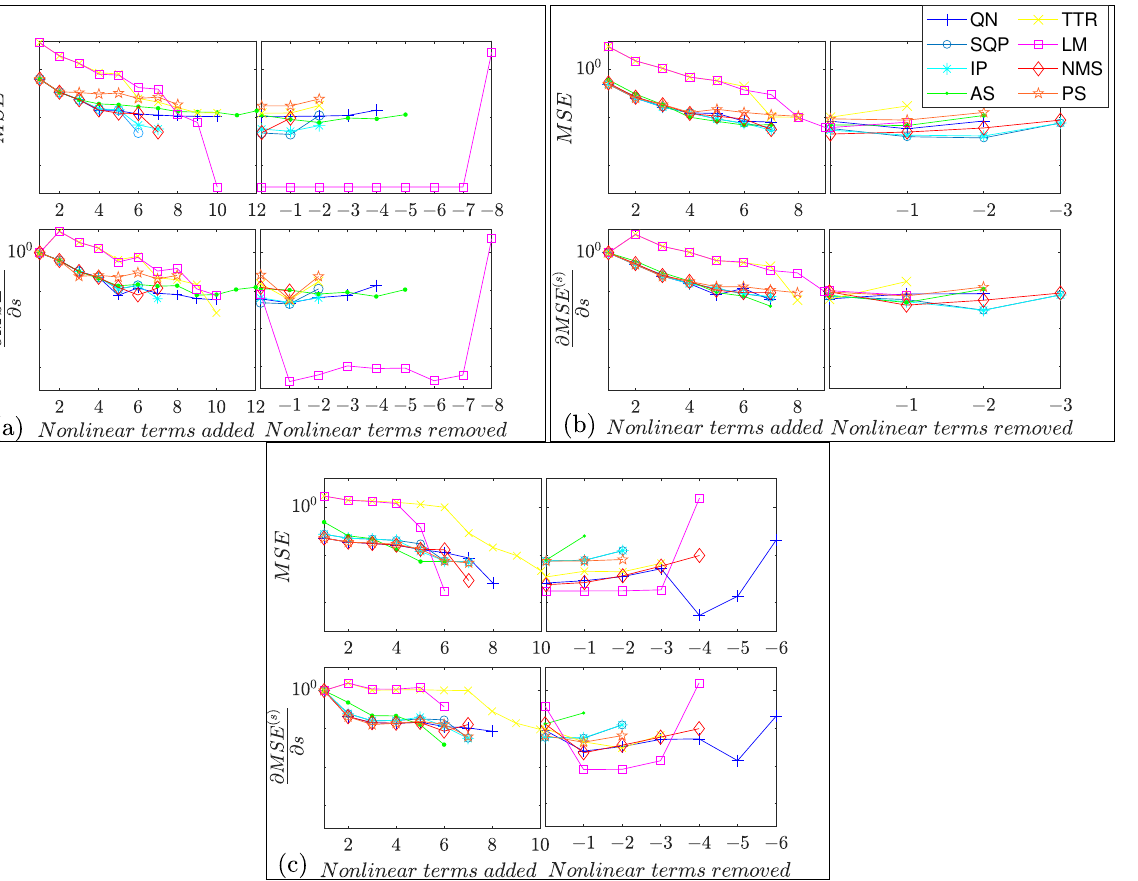
Figure 4. Model selection convergence curves for FB algorithm for the cases: ( a ) SDOF, ( b ) 3DOF, ( c ) Cbeam